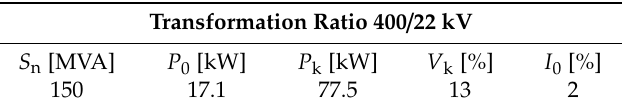
Table 4. Electrical data of the HV / MV transformers.